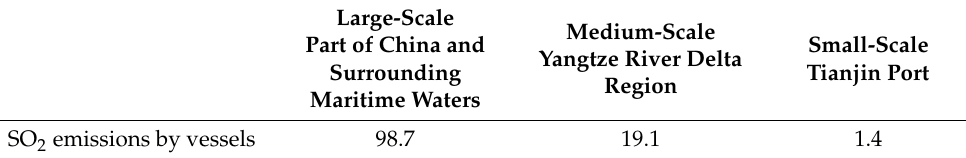
Table 4. Computed results of SO 2 emissions by vessels in Method 3. Unit: 10 4